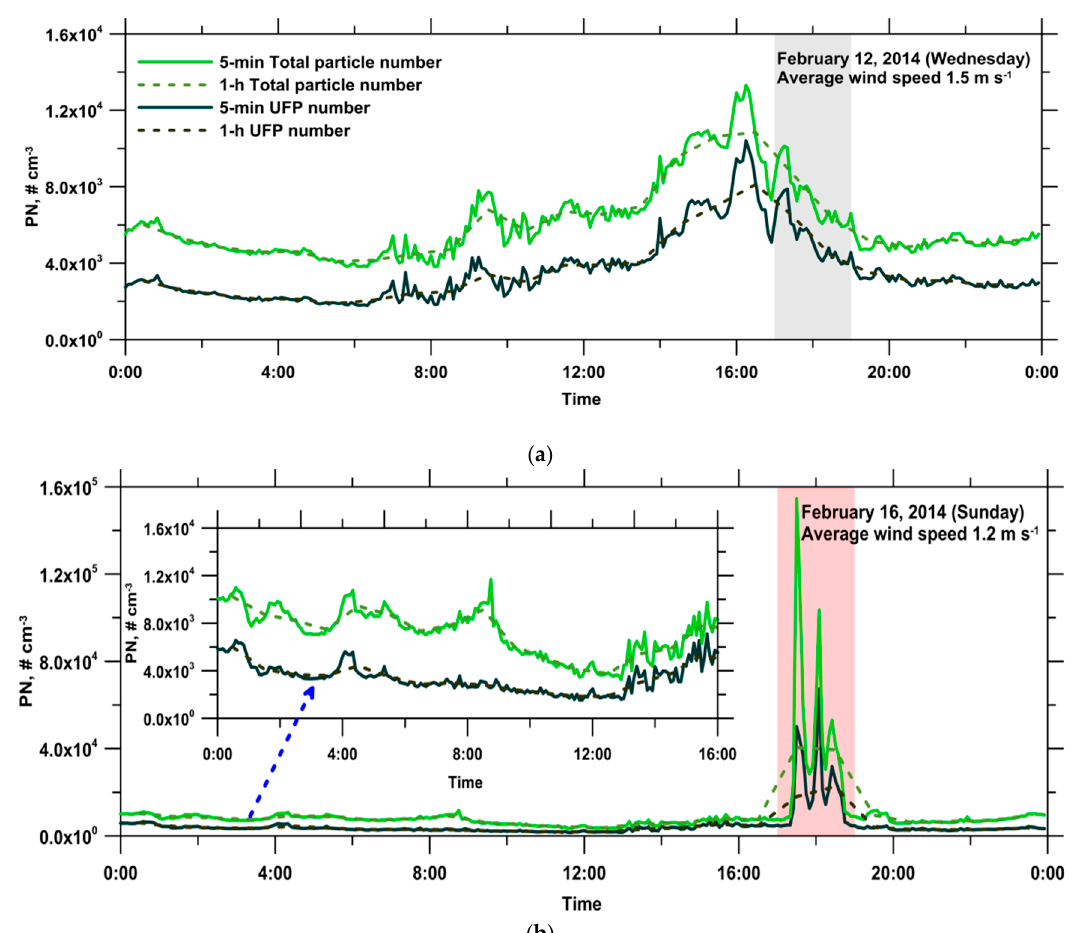
Figure 7. Diurnal variations of 5-min and 1-h total particle and UFP number concentrations at the monitoring site on ( a ) the reference day; and ( b ) the event day.